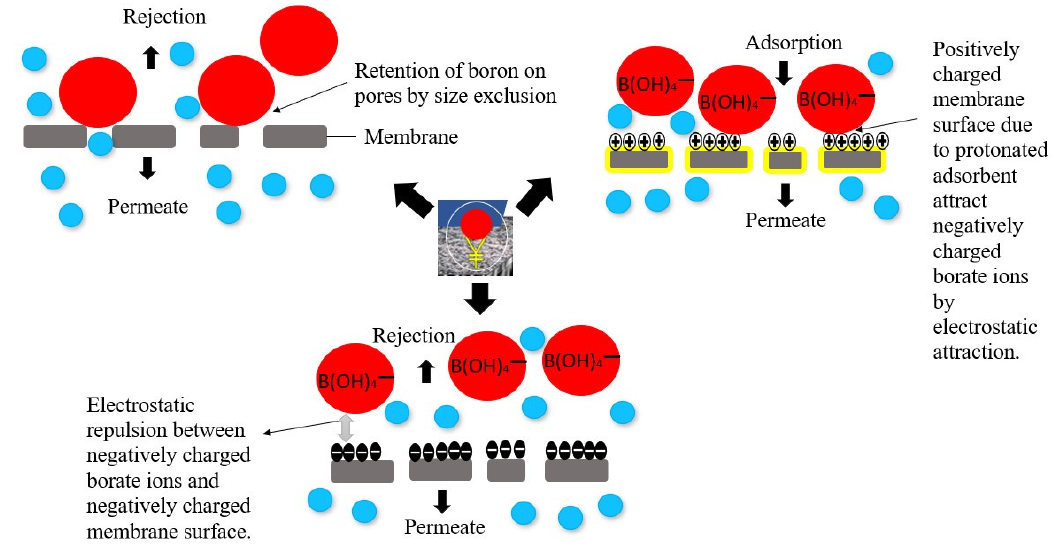
Figure 9. Possible rejection of boron from water through an adsorptive membrane.